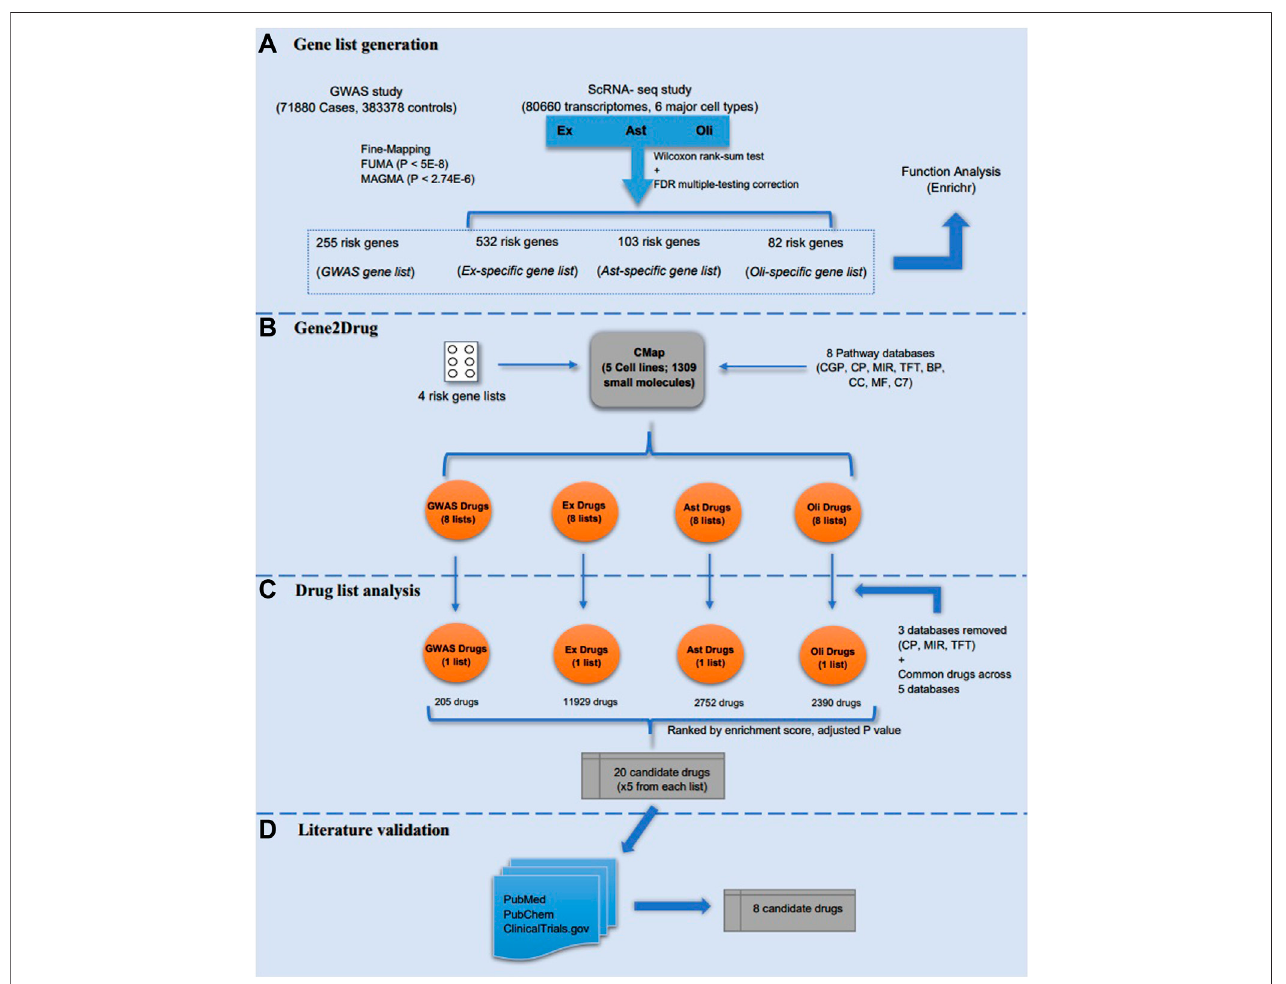
FIGURE 1 | Study design. The study included four major steps: (A) four risk genes lists (GWAS, Ex, Ast, and Oli) were generated from GWAS and scRNA-seq studies, respectively.Meanwhile,apreliminaryfunctionalanalysisofthegenelistswasperformed inEnrichr; (B) Gene2druganalysiswasthenperformedonthefourrisk gene lists by incorporating eight pathways databases; (C) drug lists were analyzed and fi ltered based on enrichment score and adjusted p -value to select top fi ve drugs from each list; (D) the identi fi ed AD candidate drugs were validated through literature review to determine the most promising candidates.